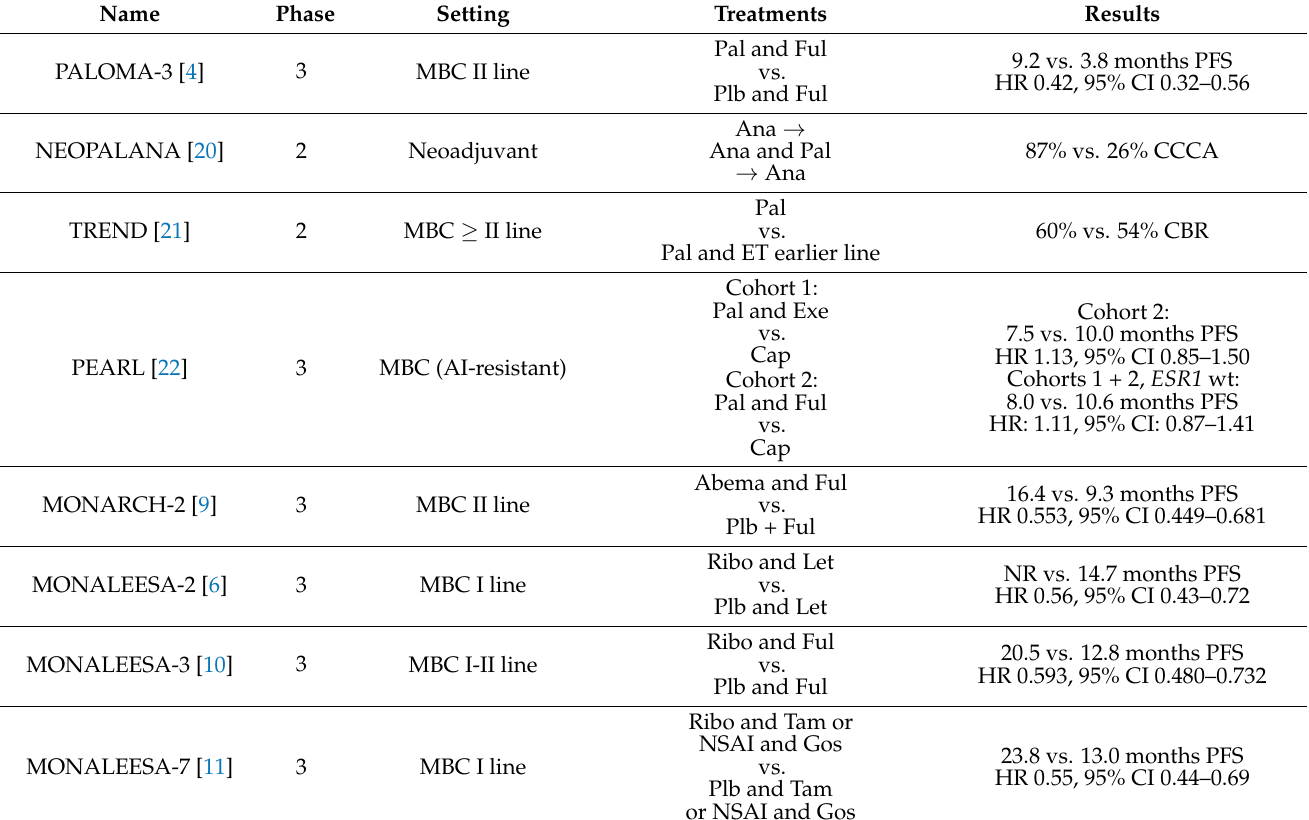
Table 1. Clinical trials on CDK4/6i in HR+/HER2 − BC with correlative studies on circulating biomarkers.